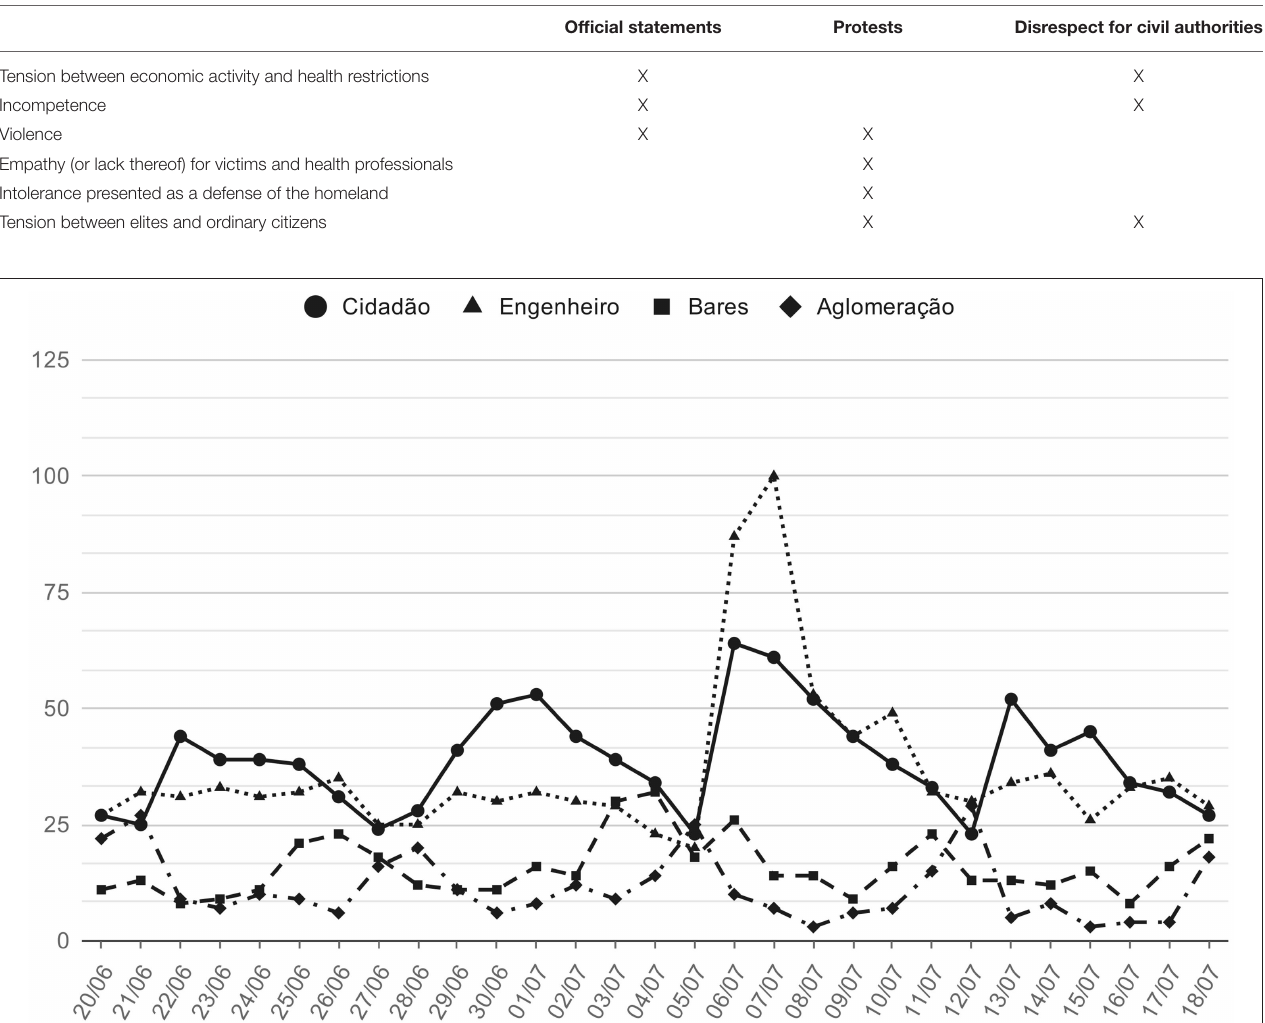
understand itself and its environment and find the best way to improve